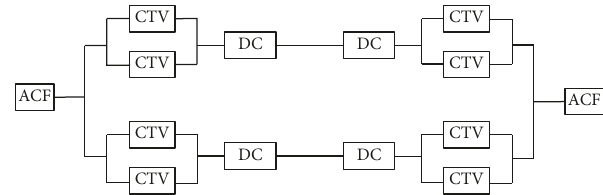
Figure 2: Logic schematic of UHVDC transmission system.